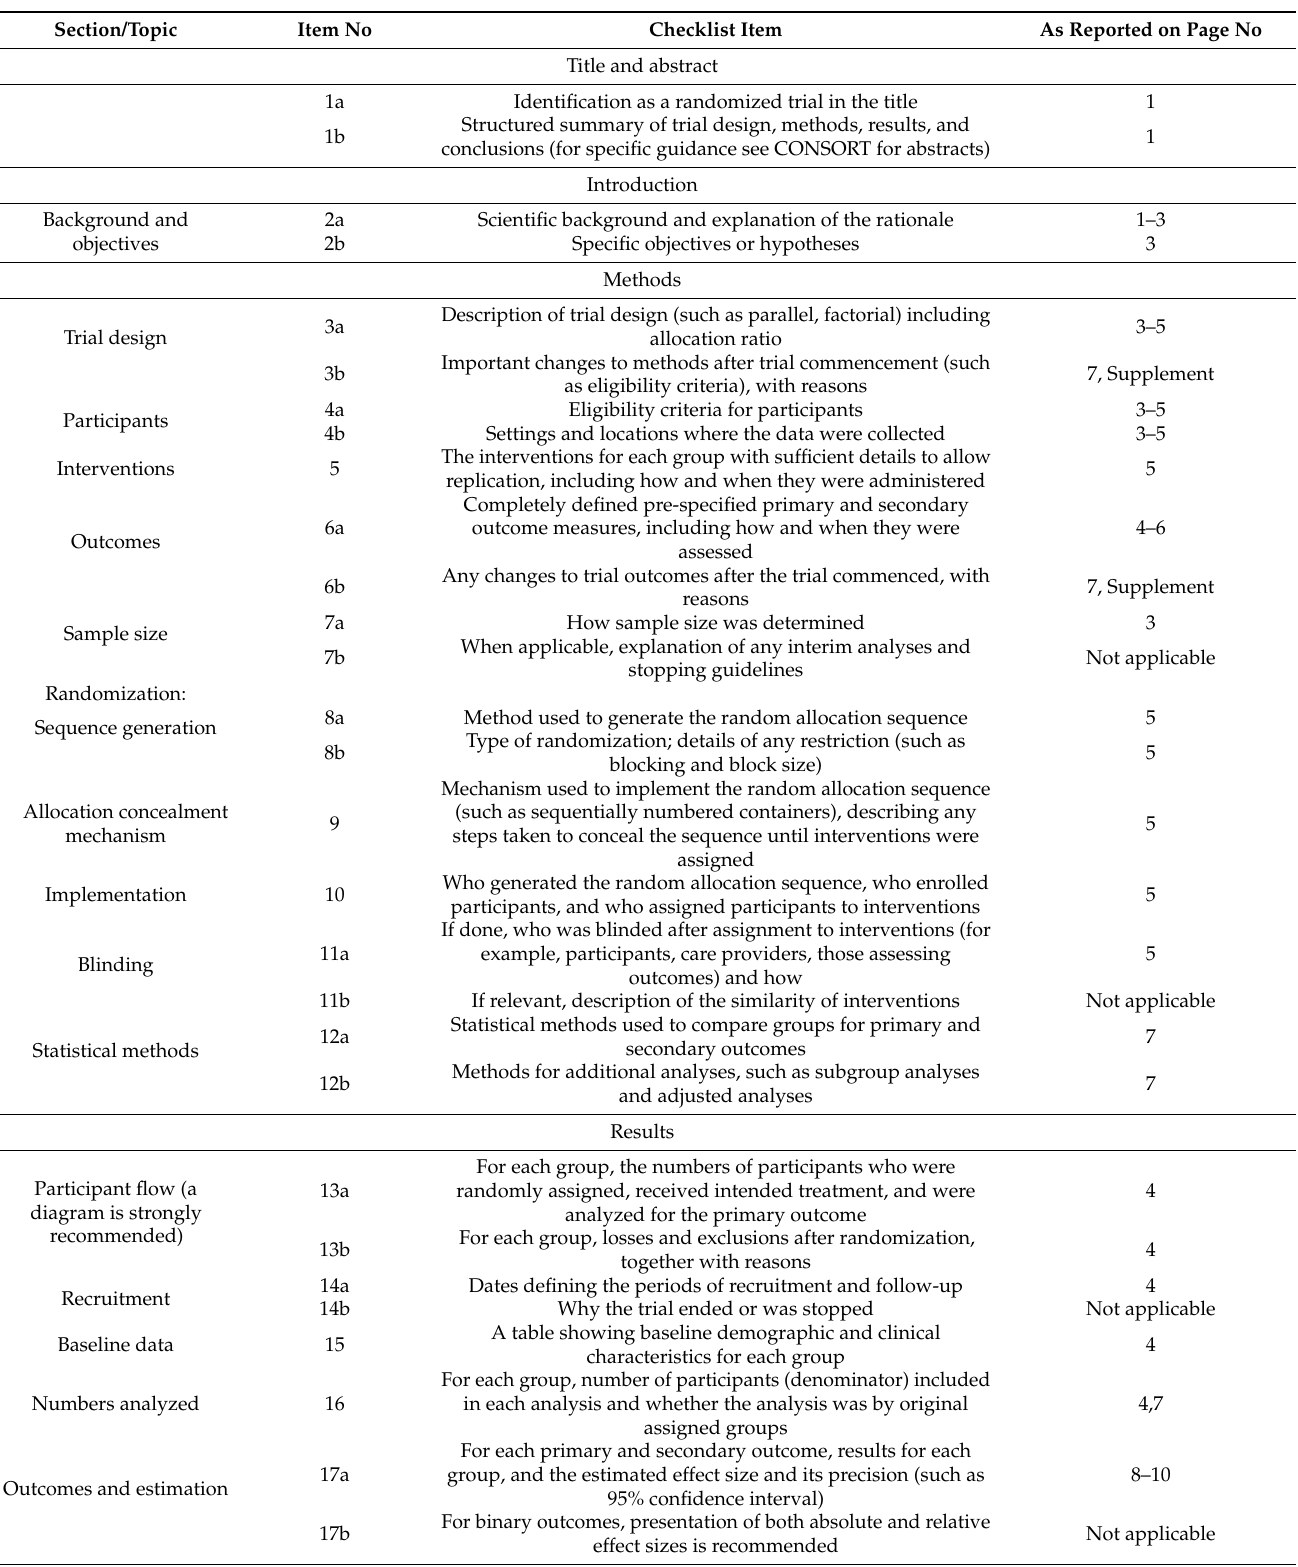
Table A1. CONSORT 2010 checklist of information to include when reporting a randomized